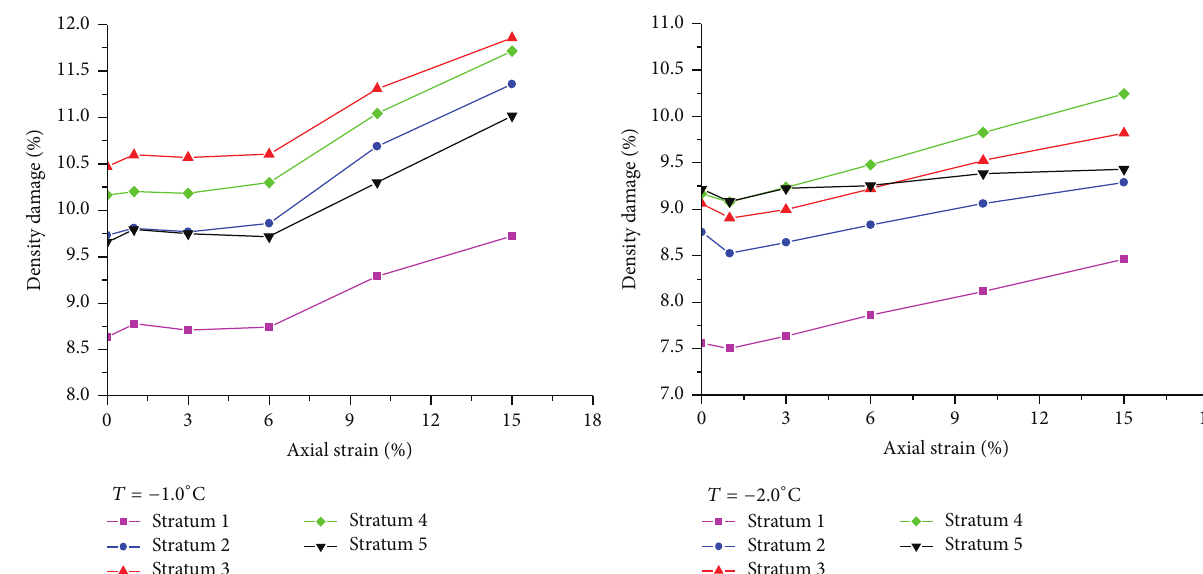
Figure 9: Distributions of density damage of warm and ice-rich frozen